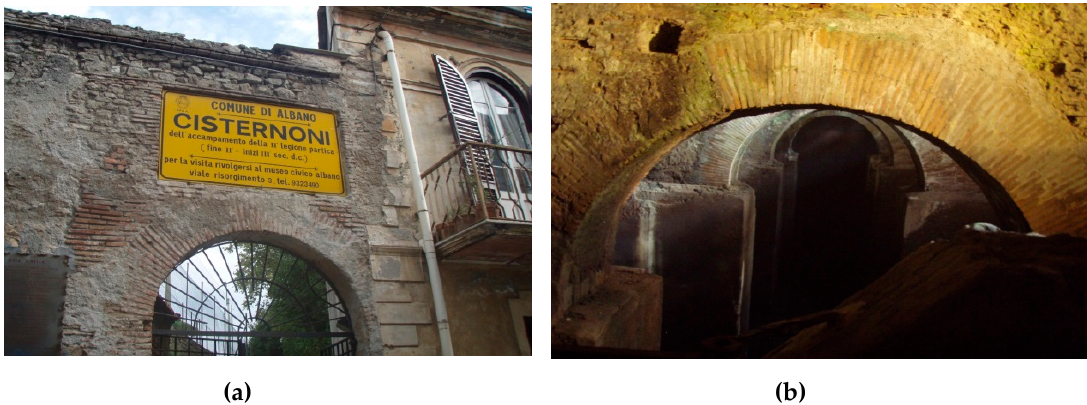
Figure 10. Cistern built by the II Legio Partica”: ( a ) access, in the Albano municipality, Italy and ( b ) view of the interior (Photo by M. Salgot).